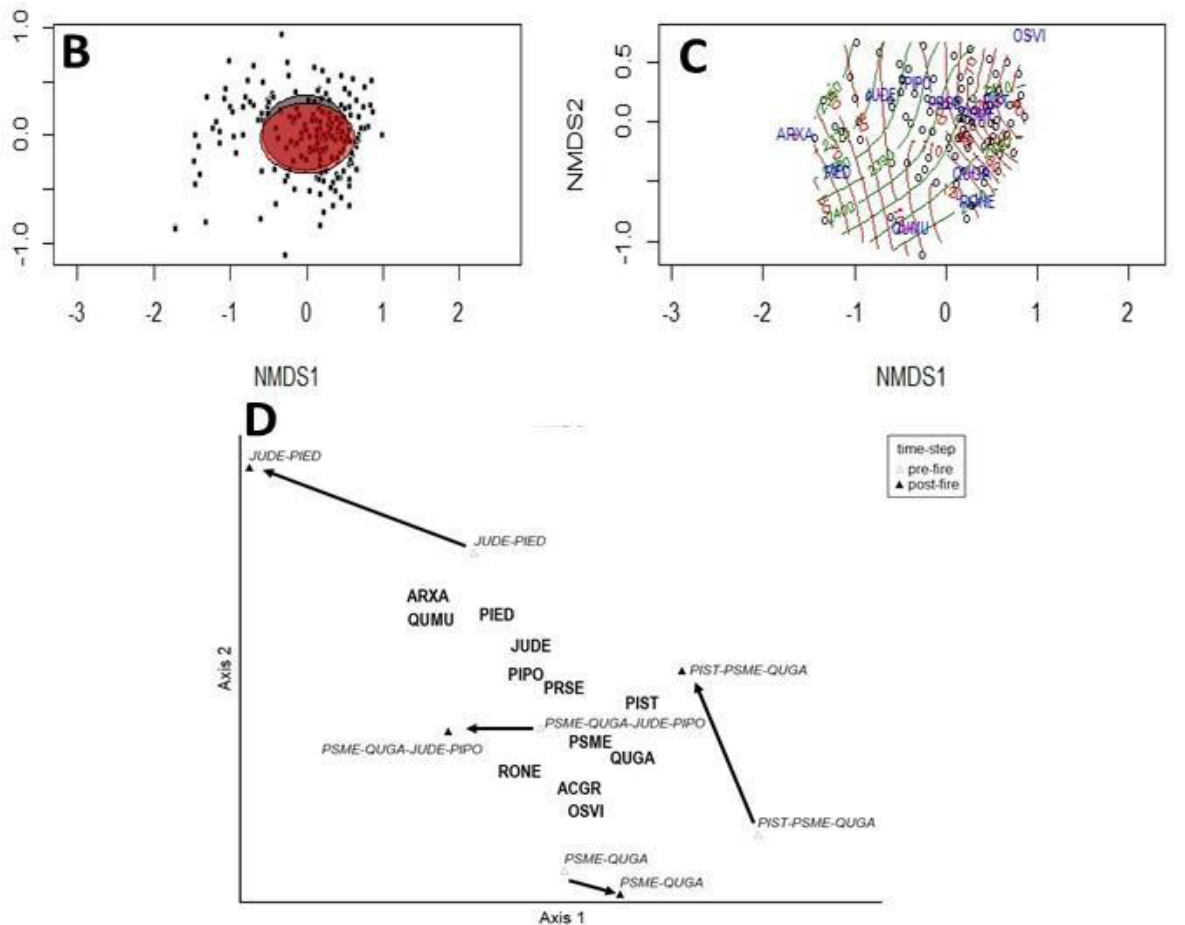
Figure 8. Non-metric multidimensional (nMDS) scaling results displaying ( A ) plots in species space for the four dominant vegetation types in Guadalupe Mountains National Park, ( B ) pre-versus post- fire plots in species space plotted with 95% confidence intervals (red = pre-fire and gray = post-fire), ( C ) Surface fits of significant ( p < 0.05) environmental variables influencing plot species composition, and ( D ) shifts in species composition by vegetation type over the time-series. Forest composition was significantly associated with elevation (red isopleths) and solar radiation (green isopleths) in panel C but did not experience a significant shift in plant community composition over time or in relation to fire severity (dNBR) according to the nMDS solution. Tree species acronyms are: Acer grandidentata (ACGR), Arbutus xalapensis (ARXA), Juniperus deppeana (JUDE), Quercus gambelli (QUGA), Quercus meuhlebergii (QUMU), Ostrya virginiana (OSVI), (PIED), Prunus serotina (PRSE), Pseudostuga menzeisii (PSME), Pinus ponderosa (PIPO), Pinus strobus (PIST), and Robinia neomexicana (RONE). Table 2. Mean species importance values for each time-step in each of the four dominant vegetation types in Guadalupe Mountains National Park. Importance values were calculated as the sum of the relative tree basal area and density for all stems in each plot. JUDE-PIED indicates the alligator juniper-piñon pine vegetation type, PSME-QUGA stands for the Douglas fir-Gambel oak vegetation type, PIST-PSME-QUGA is the southwestern white pine-Douglas fir-Gambel oak type, and PSME- QUGA-JUDE-PIPO indicates the Douglas fir-Gambel oak-alligator juniper-ponderosa pine vegeta- tion type.